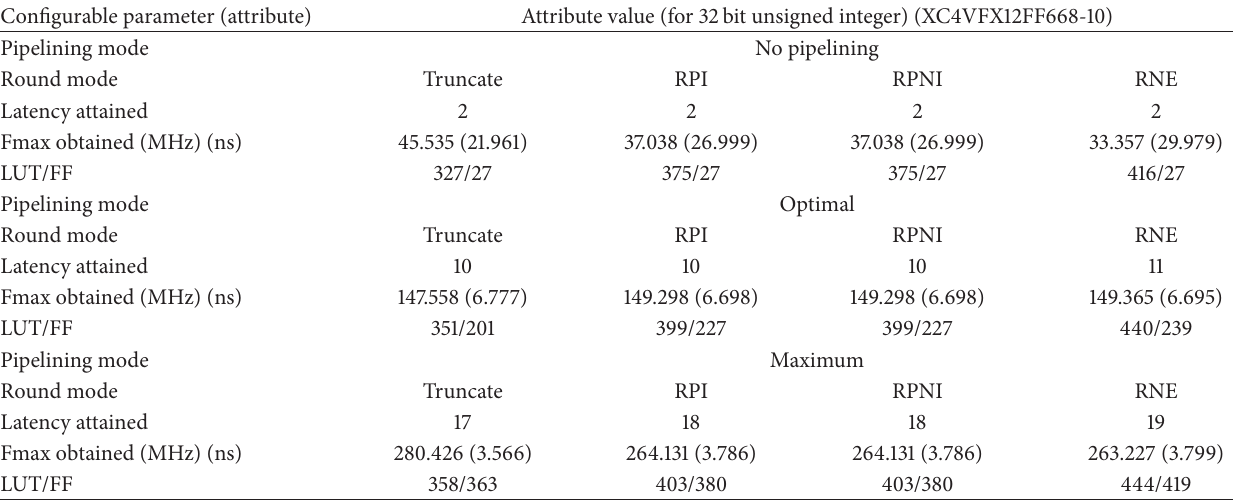
Table 13: Representative characterization data for CORDIC configured for